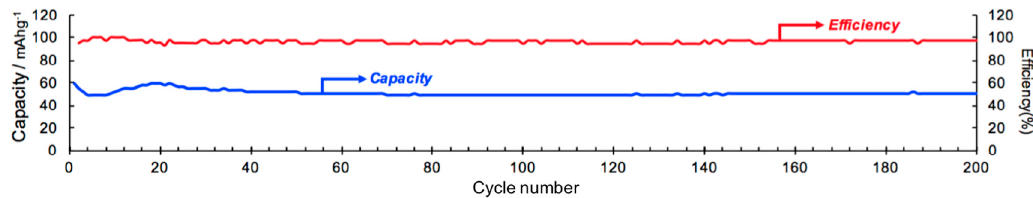
Figure 8. Capacity and e ffi ciency of Li-[28]Hex battery over 200 cycle measurement: window’s Figure 8. Capacity and efficiency of Li-[28]hex battery over 200 cycle measurement: window’s width width = 2~4 V, operation current = 2 Figure 8. Capacity and efficiency of Li-[28]hex battery over 200 cycle measurement: window’s width = 2~4 V, operation current = 2 mA. = 2~4 V, operation current = 2 mA. Figure 8. Capacity and efficiency of Li-[28]hex battery over 200 cycle measurement: window’s width = 2~4 V, operation current = 2 mA.